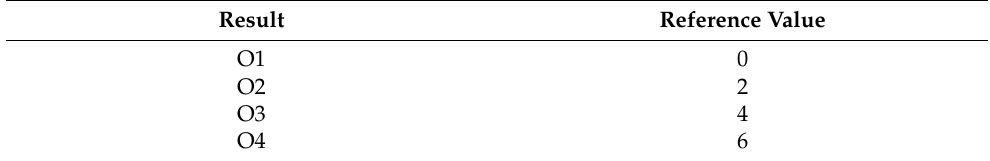
Table 6. Result and reference